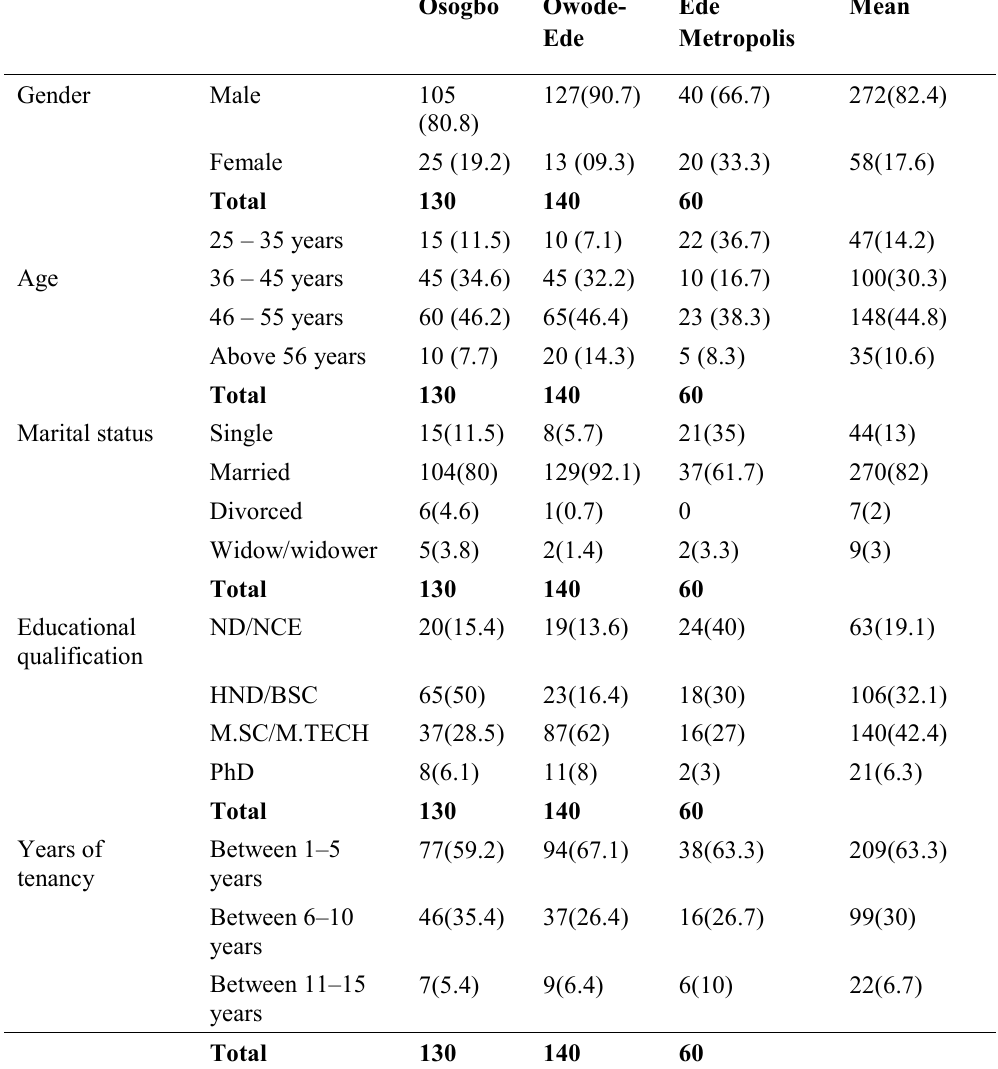
Table 1. Demographic Profile of Respondents